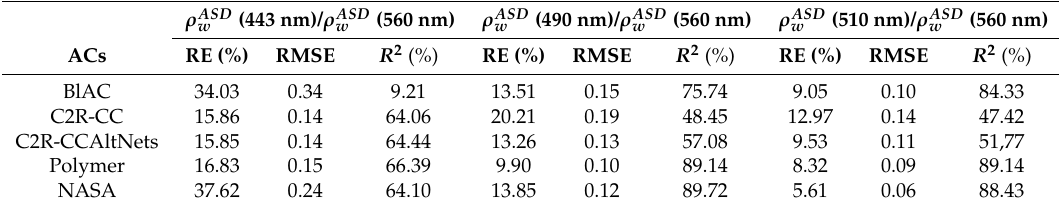
Table 4. Values of RE, RMSE, and R 2 associated with BlAC, C2R-CC, C2R-CCAltNets, Polymer, and NASA retrievals for 443/560 nm, 490/560 nm, and 510/560 nm